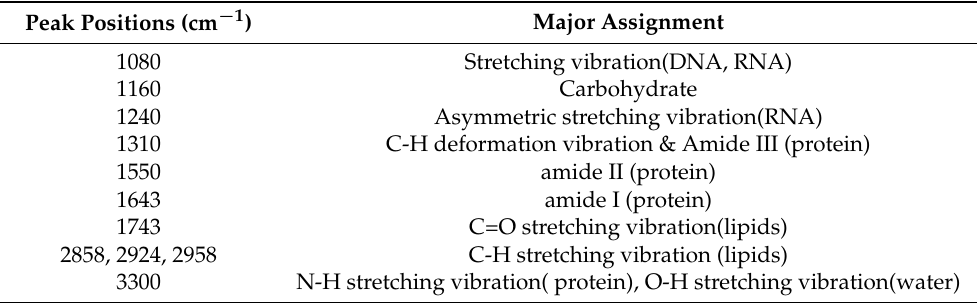
Table 1. Peak positions and assignments of FTIR bands in colon